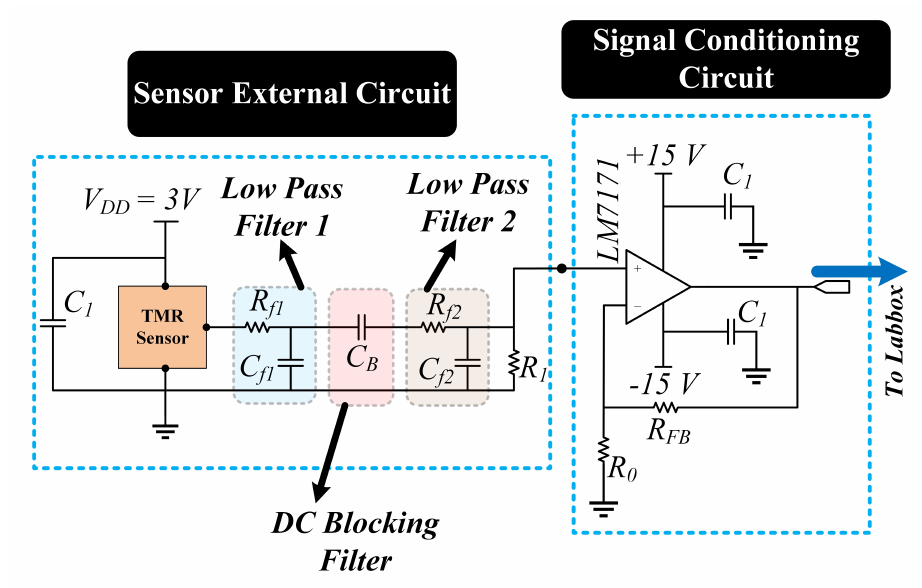
Figure 8. External magnetic sensor circuitry and the signal conditioning section.